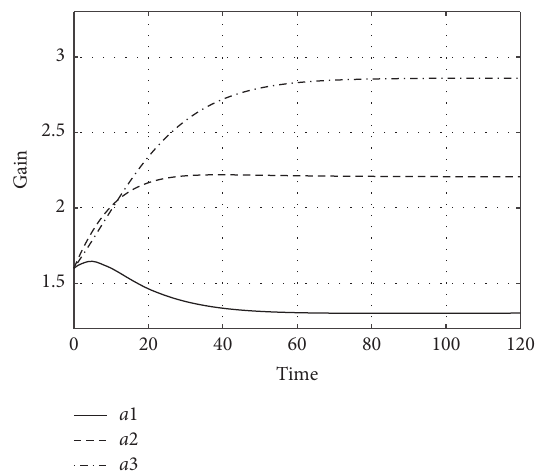
Figure 5: Gain trajectory of system with communication delay.